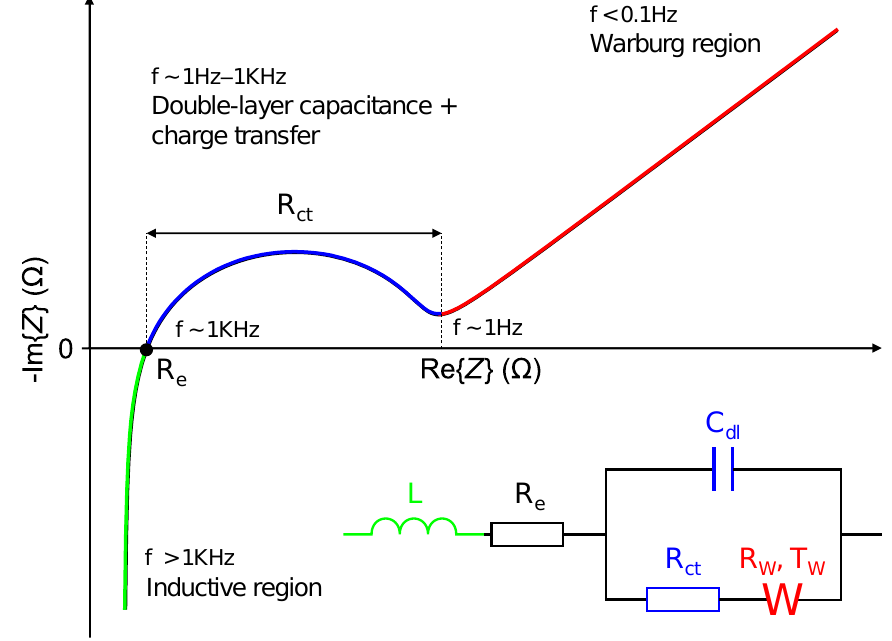
Figure 3. Schematic Nyquist representation of EIS data from a lithium-ion cell conforming to the Randles circuit model (bottom right). High-frequency phenomena (left) are modelled by an inductor L ; capacitive behaviour at mid frequencies by a parallel combination of capacitor and resistor C dl , R ct ; and solid-state diffusion (right) by a Warburg element R W , T W